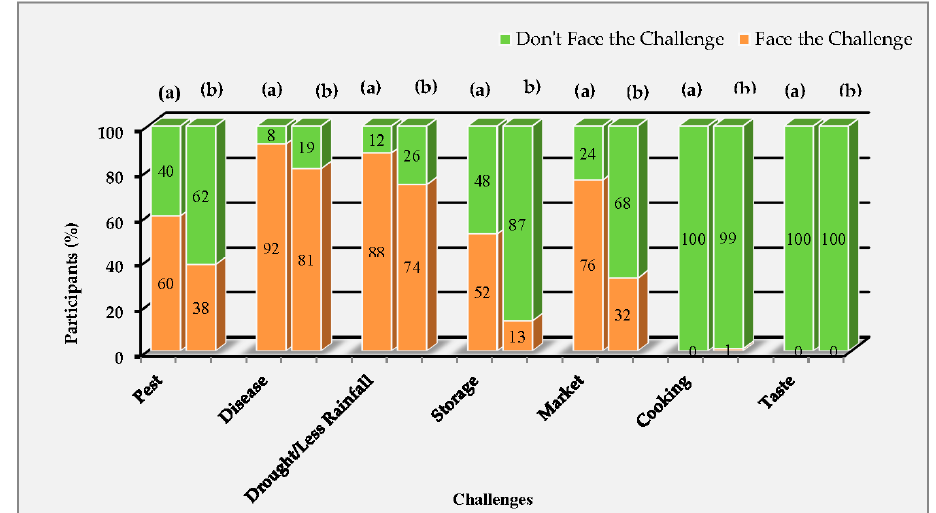
Figure 5. Participants’ challenges faced during legumes cultivation in the two study areas: ( a ) Arusha and ( b ) Kilimanjaro.